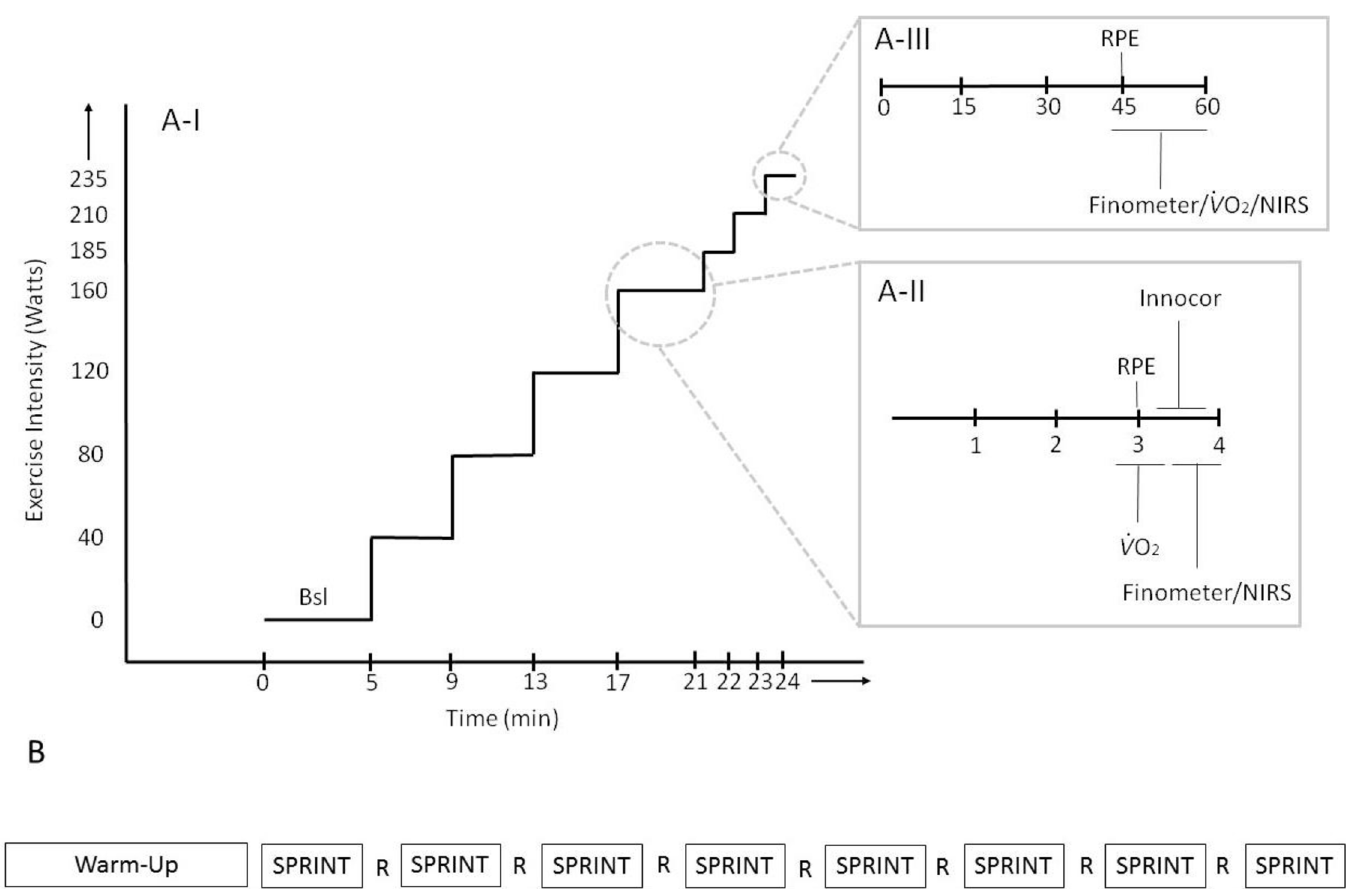
Fig 1. Experimental protocols. Panel A-I : Progressive exercise test beginning with rest and increasing by 40 W every 4 minutes until 160 W. Beyond 160 W, exercise increased by 25 W every minute until volitional exhaustion. Panel A-II : Timing of measurements (in minutes) during exercise up to 160 W. Panel A-III : Timing of measurements (in seconds) during exercise beyond 160 W. Panel B : Sprint interval training. 5 minute warm up is followed by successive 8, 20 second intervals at an intensity associated with the work rate at 170% of peak _ V O at 80 rpm. These were separated by 10 seconds of rest (loadless cycling—active recovery) at a self-selected 2 rpm, for a total of 4 minutes of exercise. RPE; ratings of perceived exertion, _ V O ; oxygen consumption, NIRS; near infrared spectroscopy, R; active recovery. 2